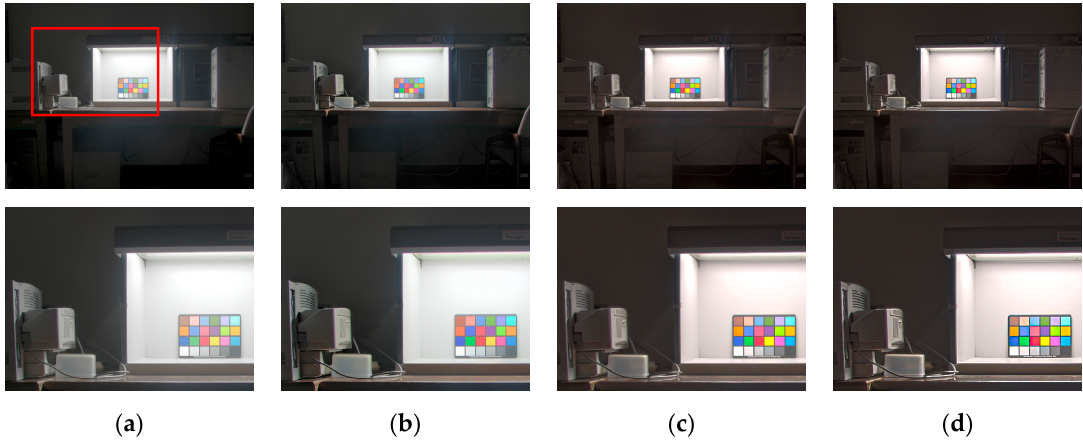
Figure 9. HDR rendered images (bookshelf). ( a ) Reinhard (2012), ( b ) Liang (2018), ( c ) iCAM06, and (d) proposed method.